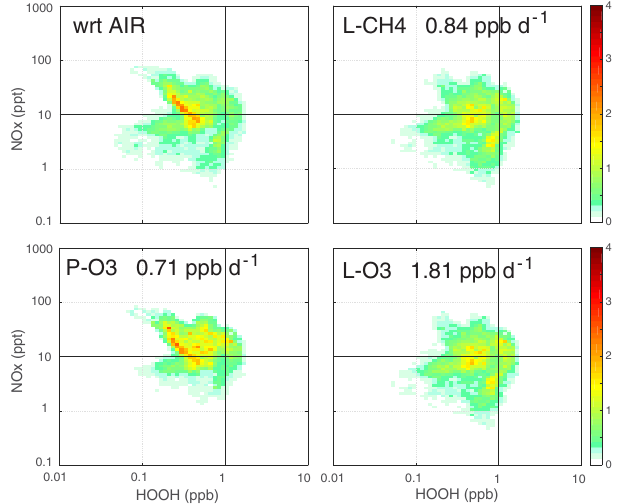
Figure 7. Model E (GMI CTM) 2-D probability distributions from A-run for NO x vs. HOOH as weighted by air mass, L-CH4, L-O3, and P-O3. The domain being sampled is 20 ◦ S–20 ◦ N, 150–210 ◦ E, 0.5–12km, see Fig.